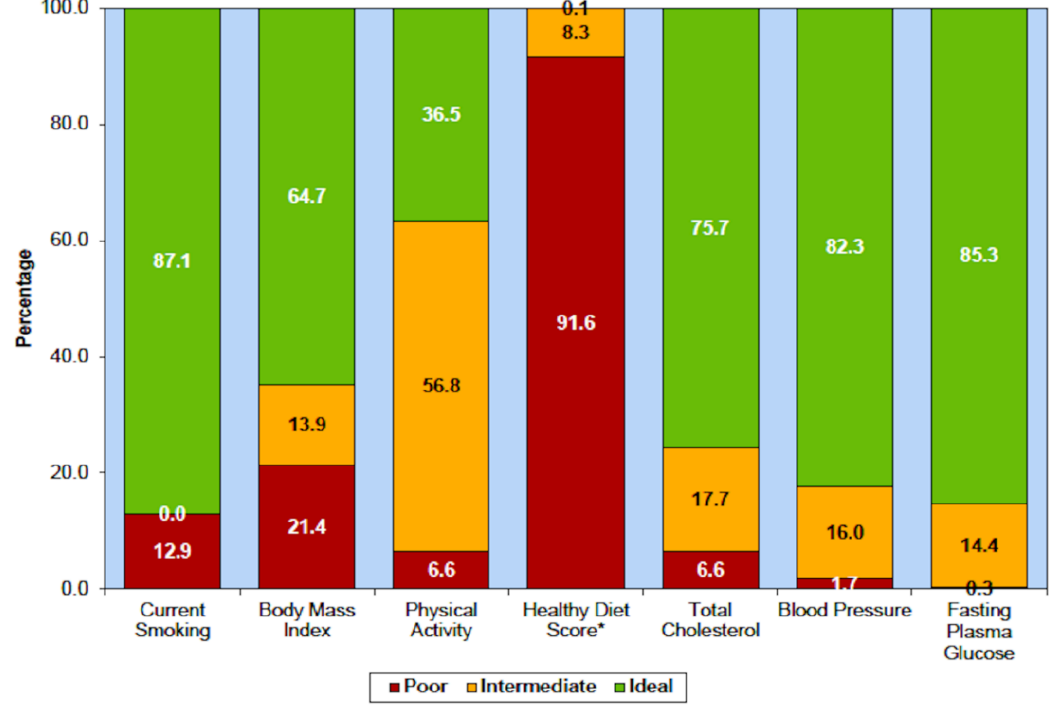
Figure 1. Diet is the worst of the risk issues in the USA. Prevalence (unadjusted) estimates for poor, intermediate and ideal cardiovascular health for each of the seven metrics of cardiovascular health in the American Heart Association 2020 goals, US children aged 12–19 years, National Health and Nutrition Examination Survey (NHANES) 2011–2012. * Healthy diet score data reflect 2009–2010 NHANES data. (Reproduced by permission of Wolters Kluwer from: Mozaffarian D, Benjamin EJ, Go AS, Arnett DK, Blaha MJ, Cushman M, et al. Heart disease and stroke statistics—2015 update: A report from the American Heart Association. Circulation. 2015;131(4): e29–322.).